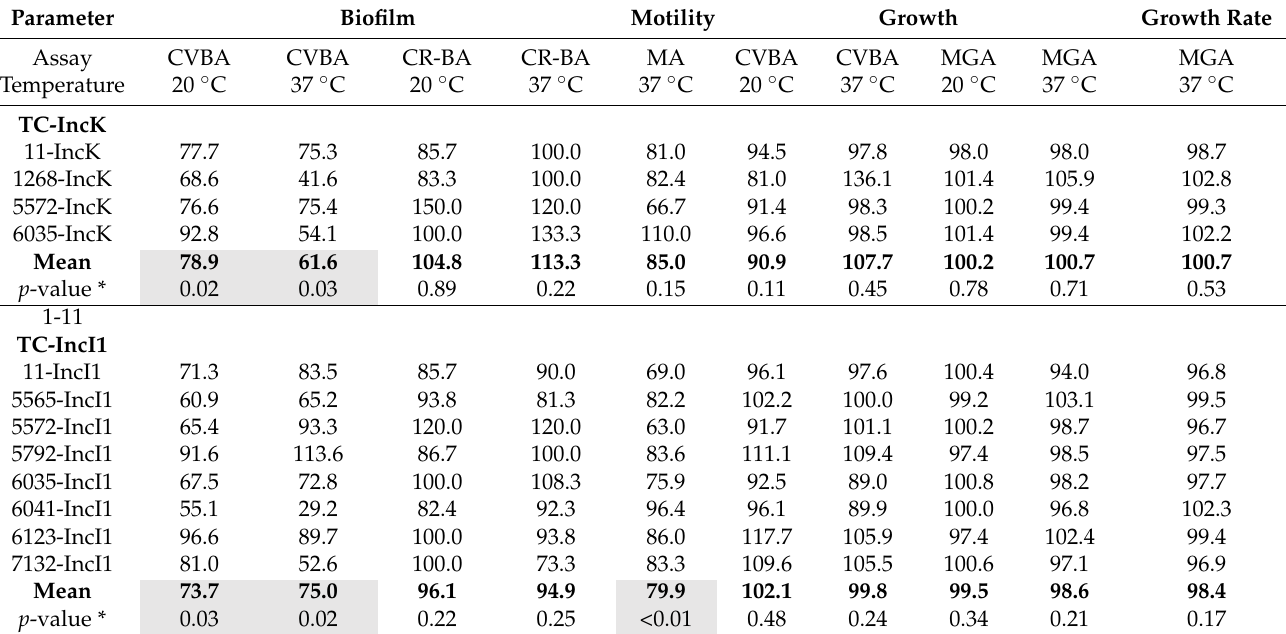
Table 8. Mean relative levels of biofilm production, motility and growth by each transconjugant (TC) as compared to their respective recipient (R), expressed as % of R. Means of all TCs with the same plasmid are highlighted with bold numbers. Statistically significant differences between TCs and Rs ( p < 0.05) are highlighted with a grey